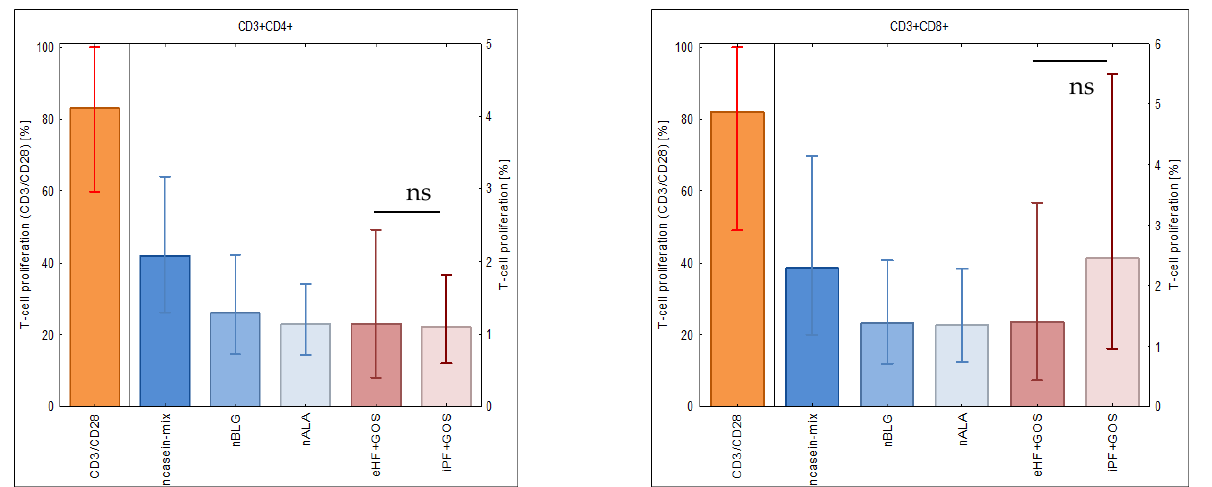
Figure 4. T cell proliferation specific for milk allergens, eHF + GOS and iPF + GOS. Shown are the back-transformed mean percentages +/- SEM of proliferated CD4 + (left part) and CD8 + T cells (right part) measured in PBMC samples from subjects 48 – 56 (Table 1) that had been stimulated with anti-CD3 and anti-CD28 (positive control), milk allergens or two milk products ( x -axis; Table 2). Only eHF and iPF were compared statistically (ns, not significant).